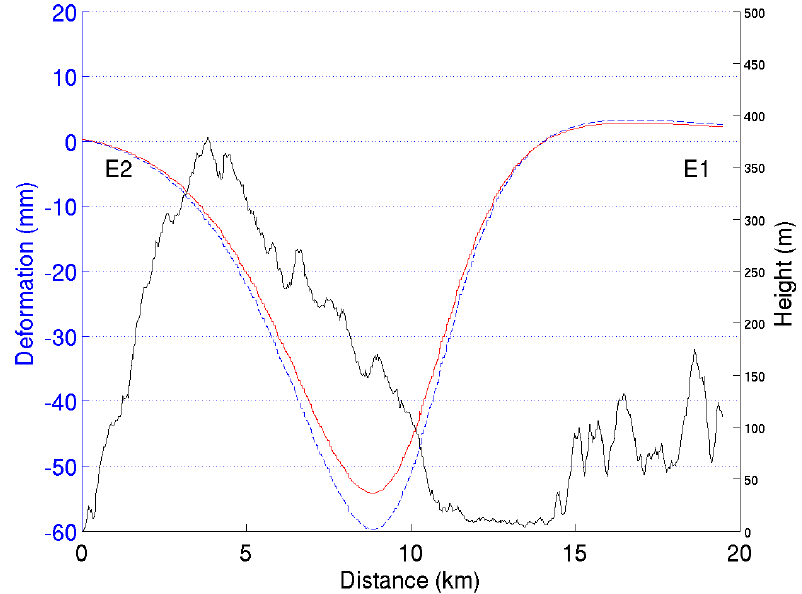
Figure 11. Cross-section E1-E2 showing LOS motion (in mm; red line) orthogonal to fault’s strike along with topography (in m) from ASTER sensor. Blue line indicates the displacement according to the average incidence angle. ASTER GDEM is a product of METI and NASA.